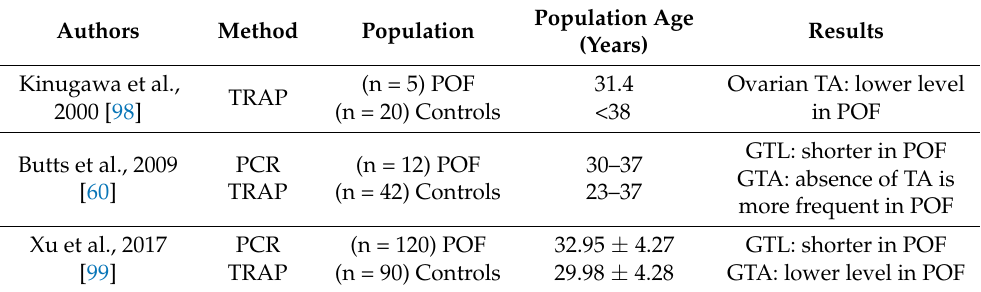
Table 4. Studies associating telomere length and telomerase activity in granulosa cells/ovaries with POF.